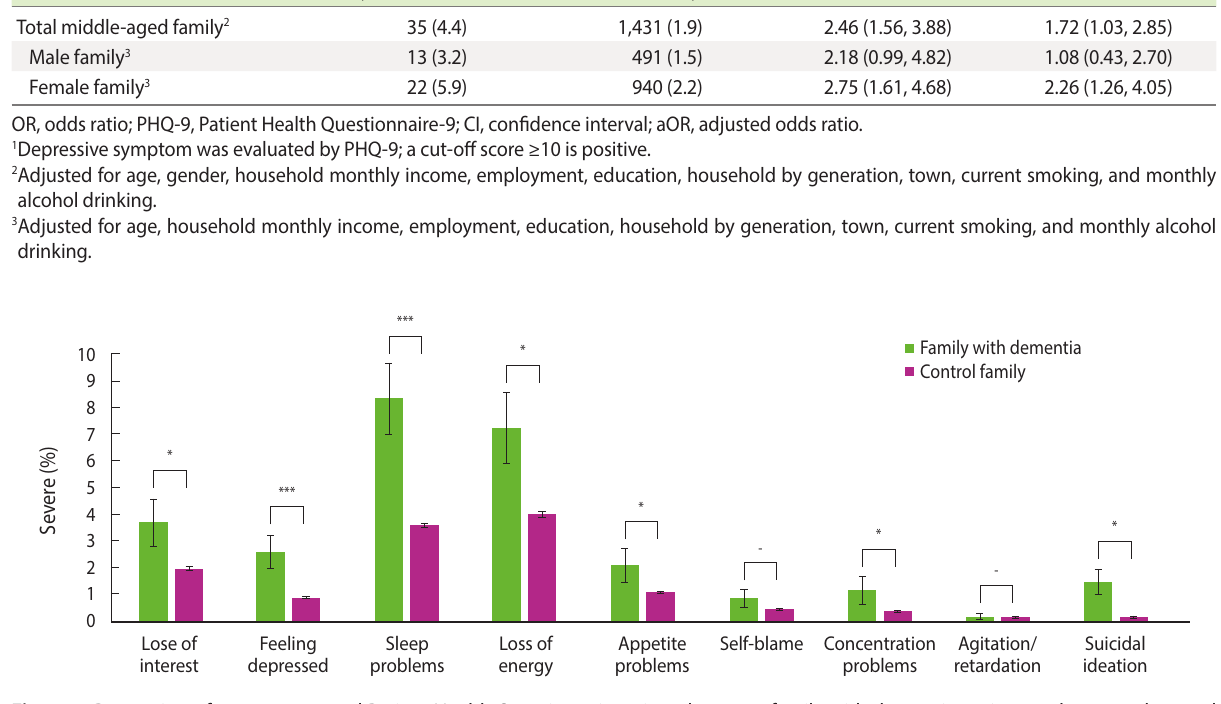
Figure 2. Proportion of severe answered Patient Health Questionnaire-9 item between family with dementia patients at home and control family. *p<0.05, Table 4. Positive rate of Patient Health Questionnaire-9 (PHQ-9) each questions among middle-aged people between family with dementia patients at home and control family Variables